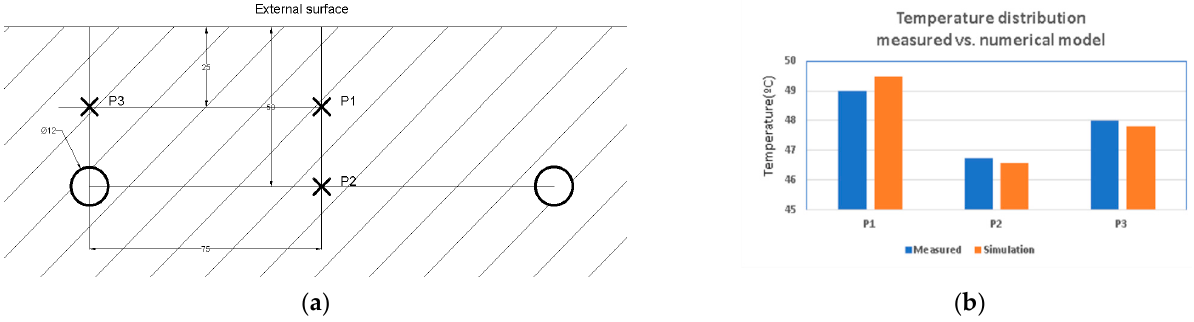
Figure 9. ( a ) K-type sensor position ( b ) graphic comparison between measured and simulated data.